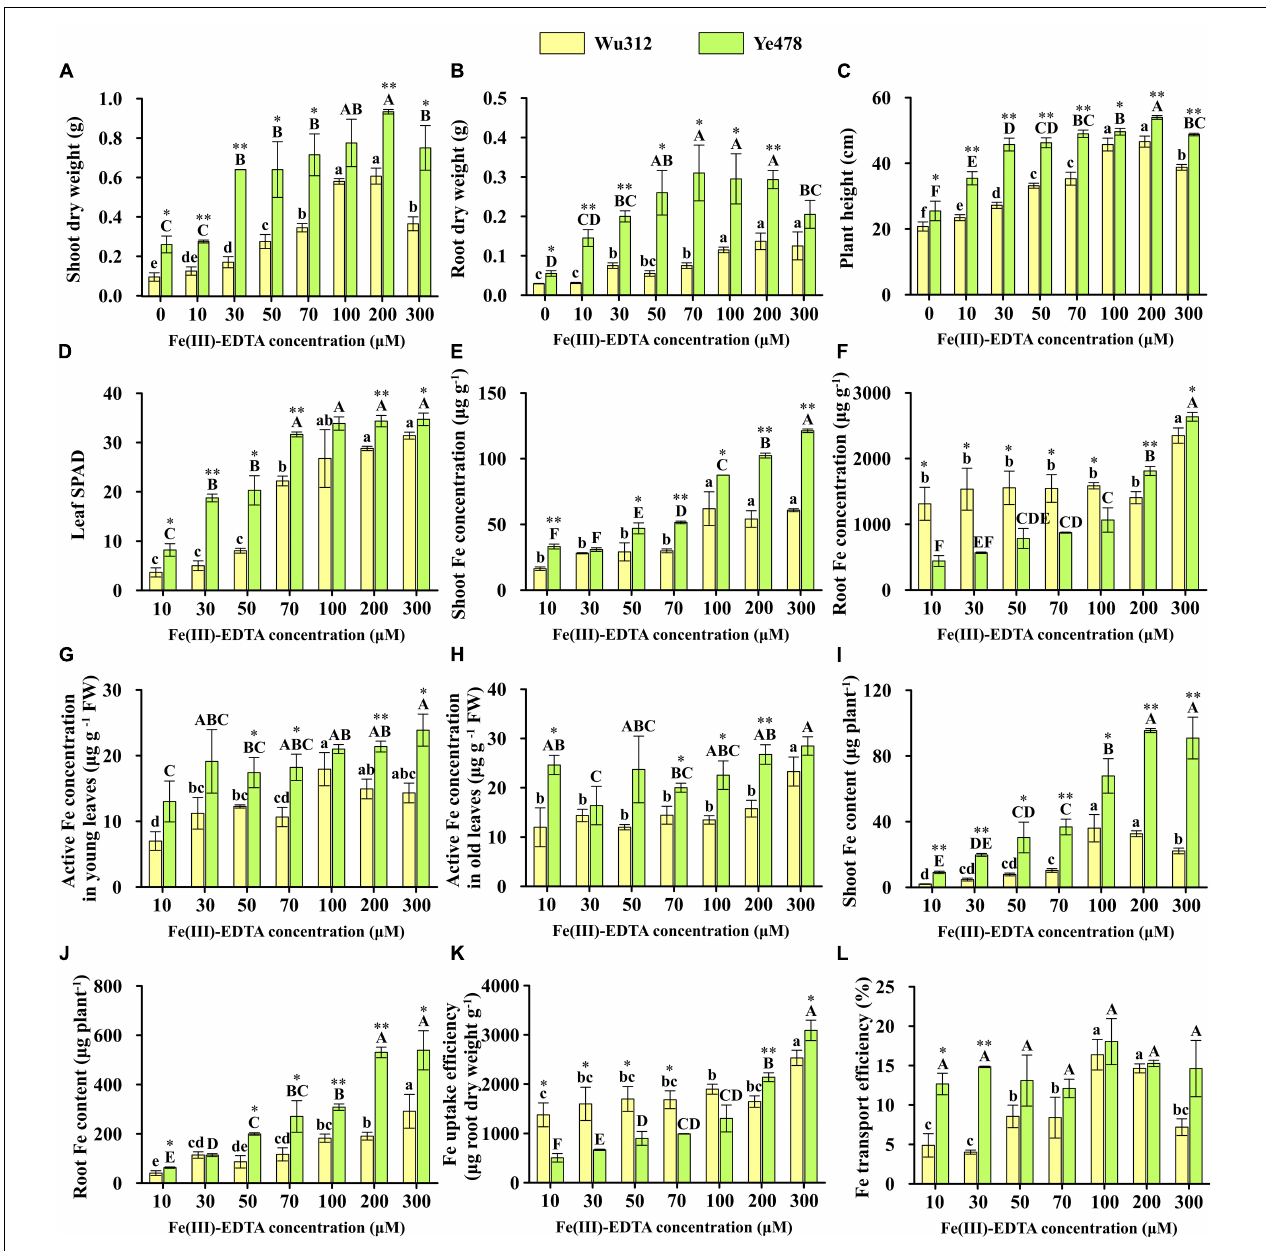
FIGURE 2 | Shoot (A) and root dry weights (B) , Plant height (C) , SPAD value of the fourth leaf (D) , shoot (E) and root Fe concentrations (F) , active Fe concentration in young leaves (G) and old leaves (H) , shoot (I) and root Fe contents (J) , Fe uptake (K) , and transport (L) efficiencies of Fe-inefficient inbred line Wu312 and Fe-efficient inbred line Ye478 under different Fe(III)-EDTA levels in Experiment 1. Different lowercase and upper letters indicate significant difference ( p < 0.05) of Wu312 and Ye478 among treatments, respectively. * and ** indicate significant difference between Wu312 and Ye478 at p < 0.05 and p < 0.01, respectively.